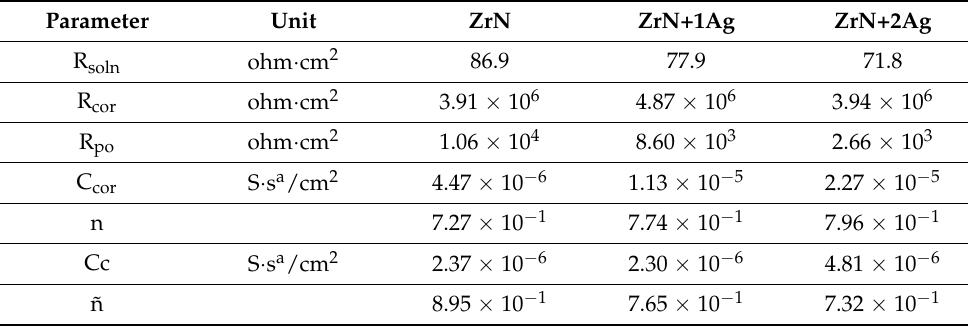
Table 6. EIS fitting parameter of ZrN, ZrN+1Ag and ZrN+2Ag coatings after 1 h of immersion on a Ringer’s solution at 37.5 ◦ C.